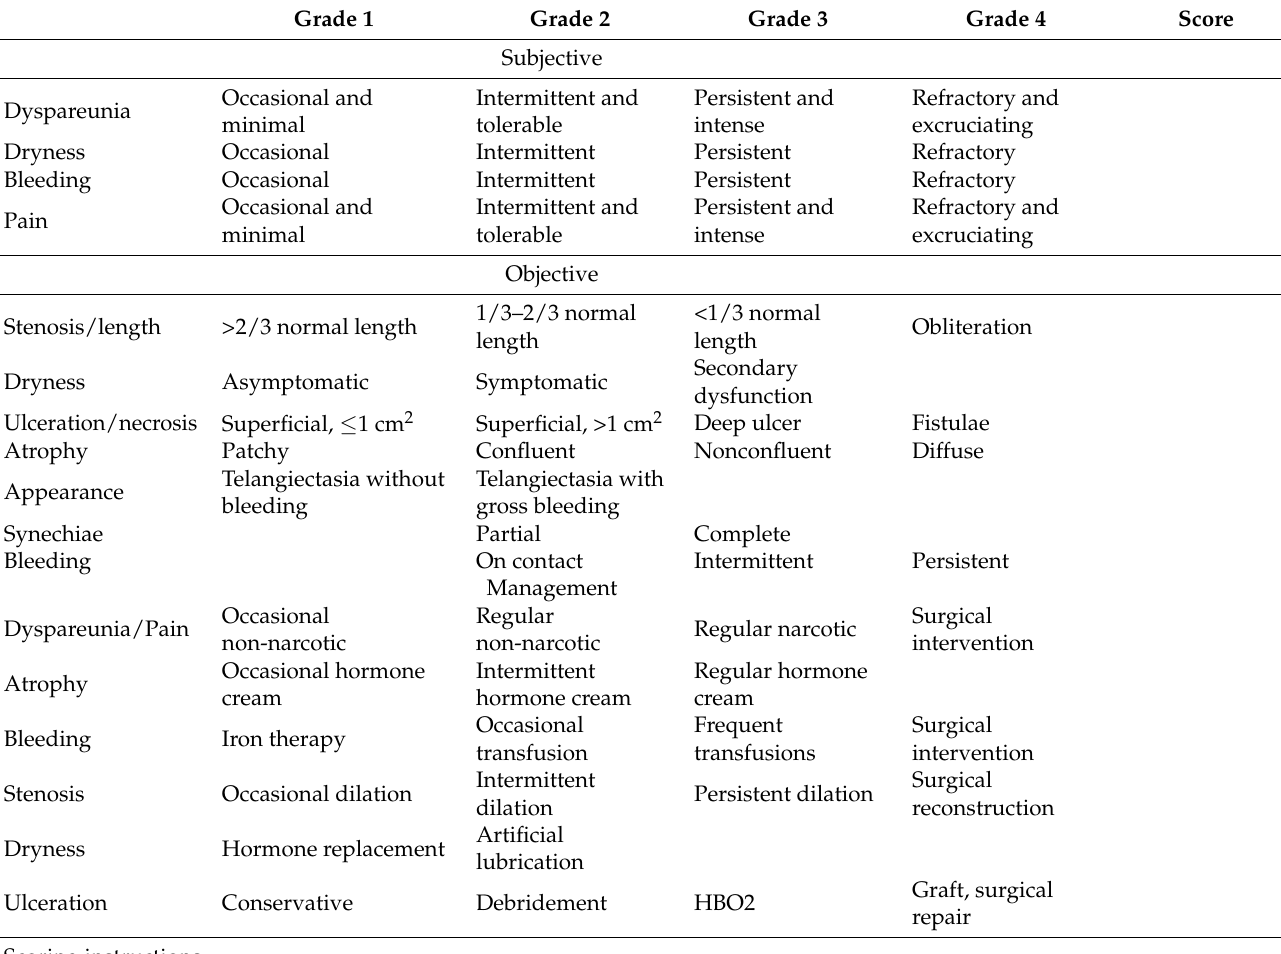
Table 2. Radiation Therapy Oncology Group (RTOG)/European Organization for the Research and Treatment of Cancer (EORTC) late effects of normal tissues, subjective, objective, management (LENT-SOMA) scoring table for injury to the